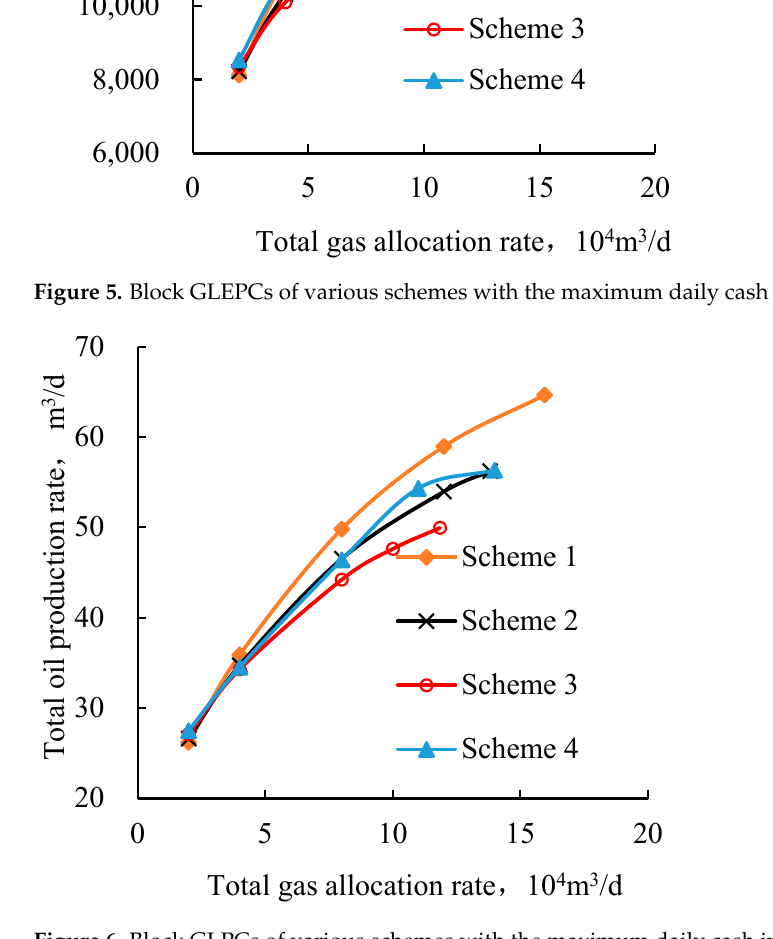
Figure 6. Block GLPCs of various schemes with the maximum daily cash income NPV.